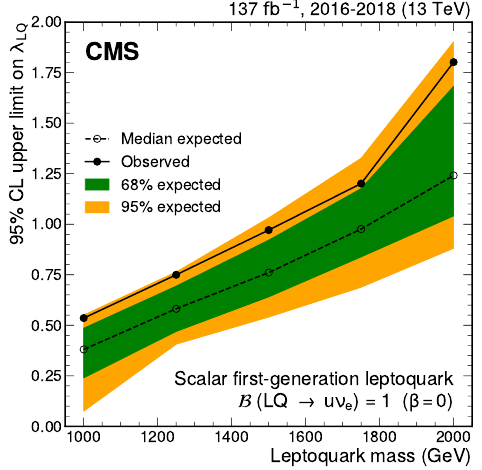
as a function of the leptoquark LQ